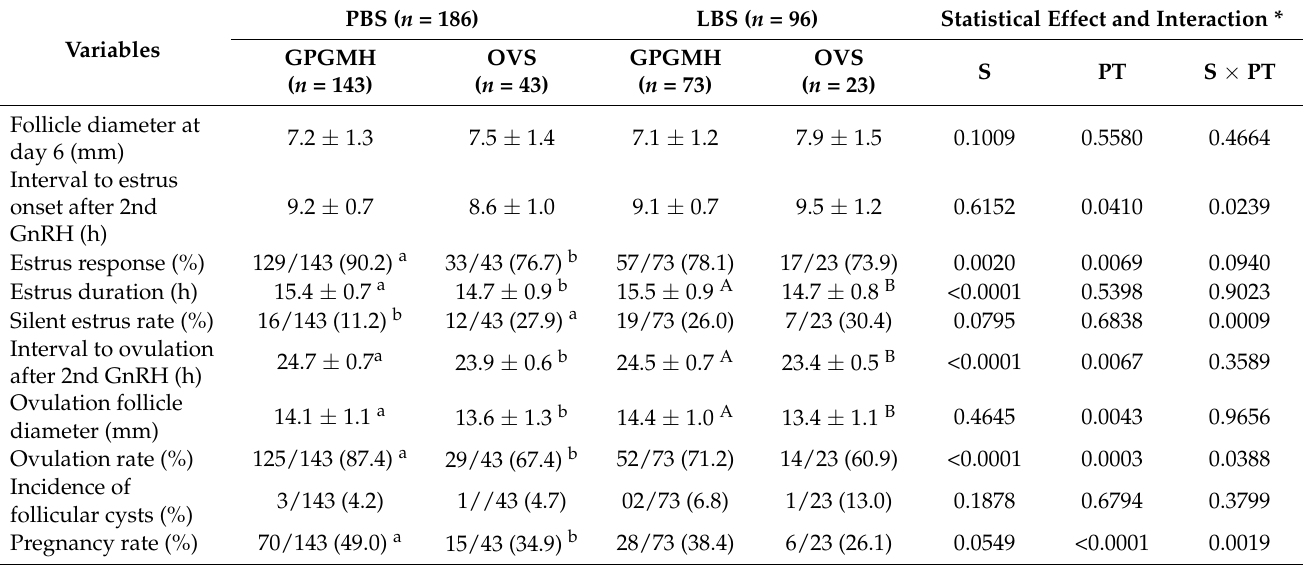
Table 3. Effect of season [peak breeding season (PBS) vs. low breeding season (LBS)], synchroniza- tion protocol (GPGMH and OVS), and interactions on follicular dynamics, estrus, ovulation, and pregnancy in crossbred